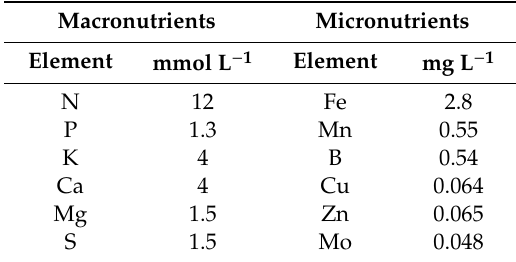
Table 1. Nutrient solution used in the